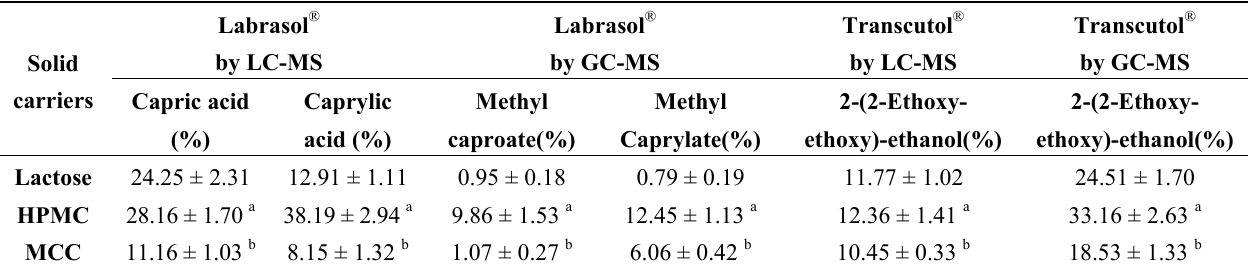
Table 4. Retention ratios of Labrasol ® and Transcutol ® in solid SMEDDS after spray- drying determined by LC- and GC-MS. Ratios are expressed in mean ± SD from quadruplicate